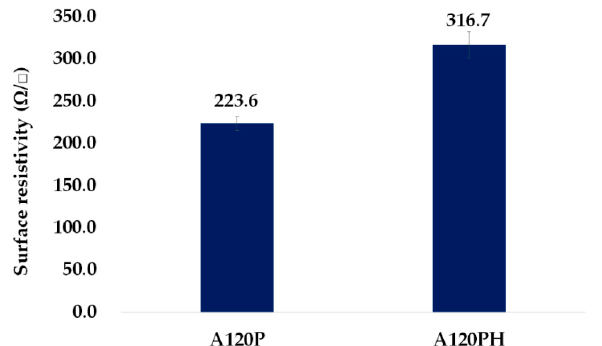
Figure 6. Surface resistivity of a sample treated with an NaOH solution and followed by PPy polymerization (A120P), and a sample treated with an NaOH solution and followed by PPy polymerization and hydrophobic coating (A120PH).